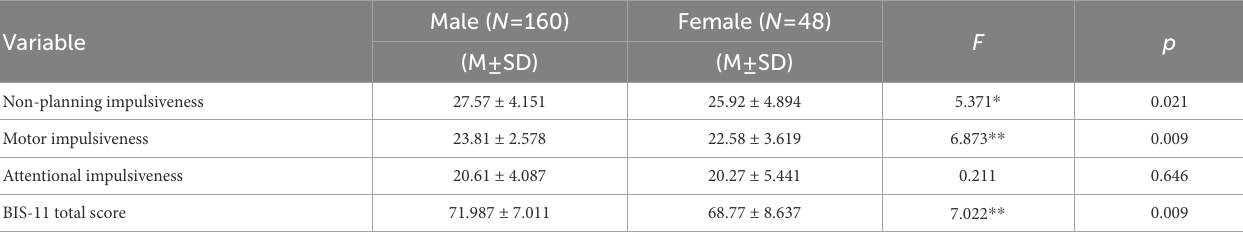
TABLE 1 Gender difference test of trait impulsivity.